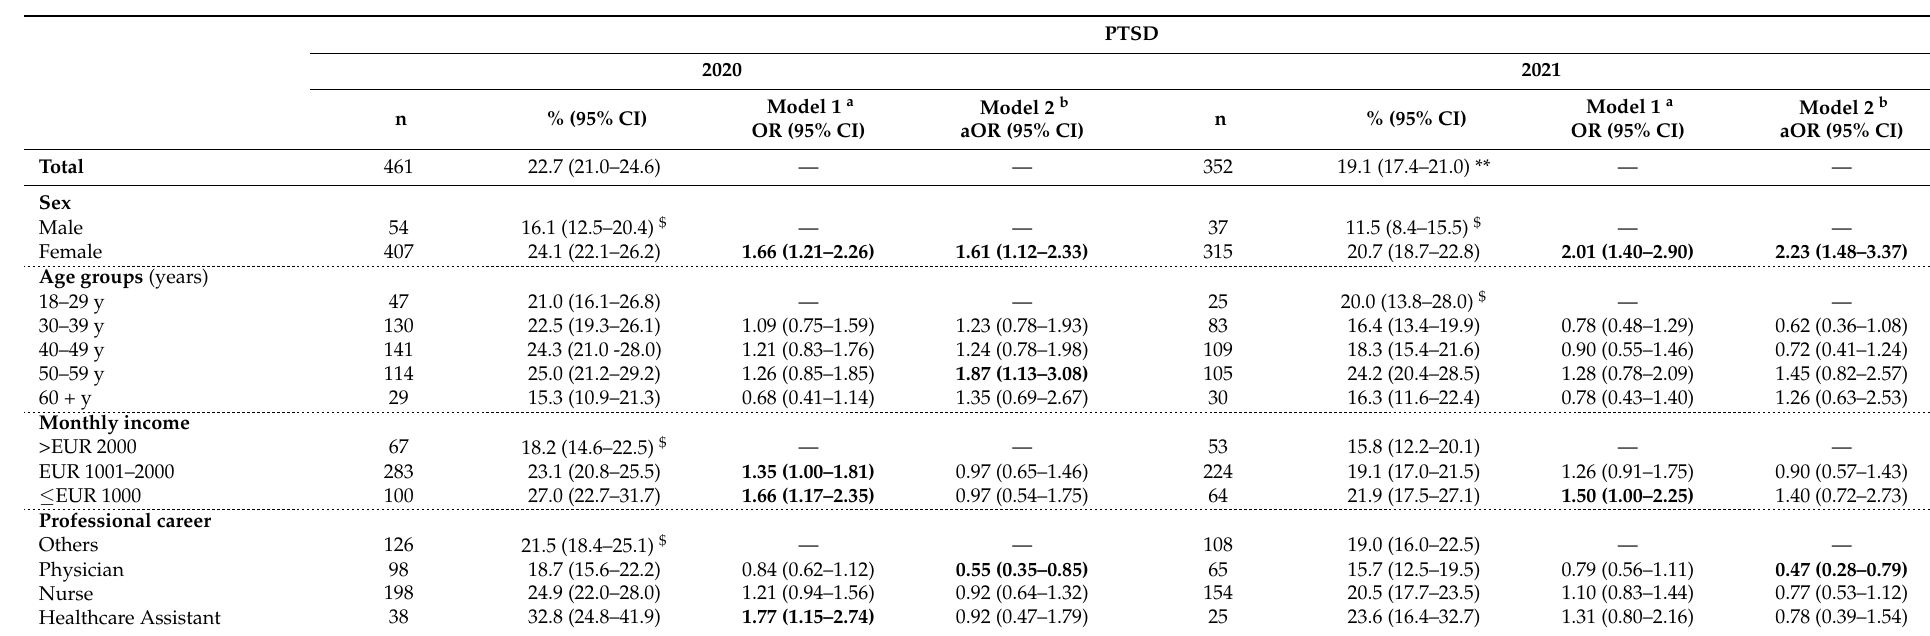
Table 4. Symptoms of post-traumatic stress disorder (PTSD) among HCPs during the first two years of COVID-19 pandemic in